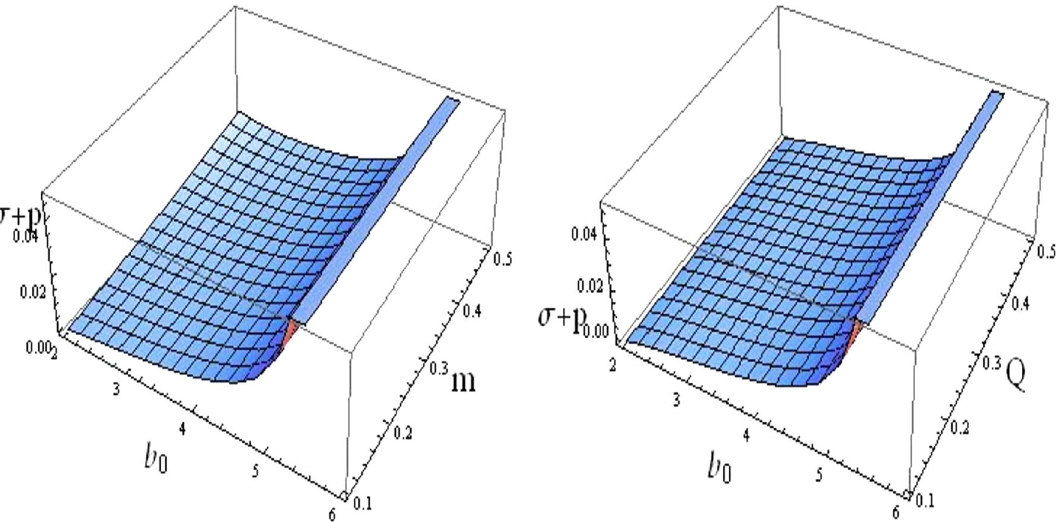
Fig. 1 Plots of the null energy condition for charged Kiselev thin-shell gravatars. We examine graphical behavior of σ + p at b = b 0 verses ( b 0 , Q ) (left plot) and ( b 0 , m ) (right plot) for ω = − 2 / 3, α = 0 . 2 and β = 0 . 5